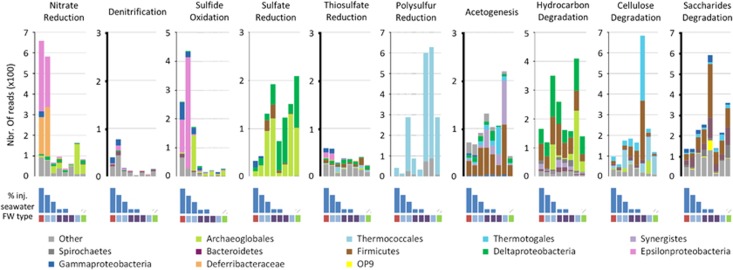
Relative proportion (x100) of selected genes in the normalized metagenomes with IMG/M taxonomic affiliation of the reads. Nitrate reduction gene: narG, Denitrification: nirK, Sulfide oxidation: sqr, Sulfate reduction: dsrAB, Thiosulfate reduction: phsA, Polysulfur reduction: hydG, Acetogenesis: fhs, Hydrocarbon degradation: bssA, Cellulose degradation: cellulase, Monosaccharide degradation: glycosylase. From the right to the left: HDA-03, HBA-05, HBA-07, HDA-13, HDA-05, HDA-06, HBB-09 and HDA-09. Blue histograms show seawater fraction on the produced fluid (not available for HDA-09) and color code below indicates the formation water type (color code is the same as in Figure 1: blue: FWA; purple: FWB; green: gas formation; red: mixed).